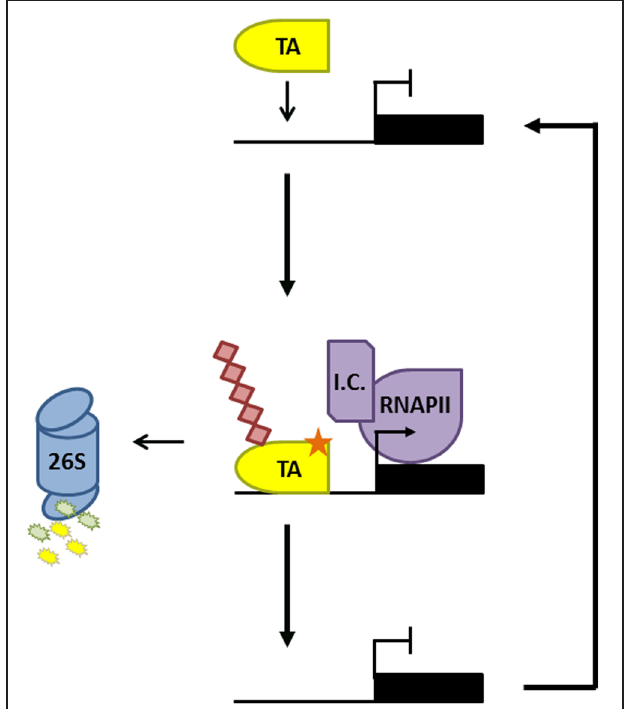
FIGURE 1 | Proteasome-mediated activator turnover activates transcription. Promoter binding of a transcription activator (TA) results in recruitment of the transcription initiation complex (IC) and RNA Polymerase II (RNAPII). The TA is subsequently phosphorylated (orange star) by a kinase within the IC, marking it for ubiquitination (red diamonds) and degradation by the 26S proteasome. This allows a new TA to bind the promoter and reinitiate a new round of gene